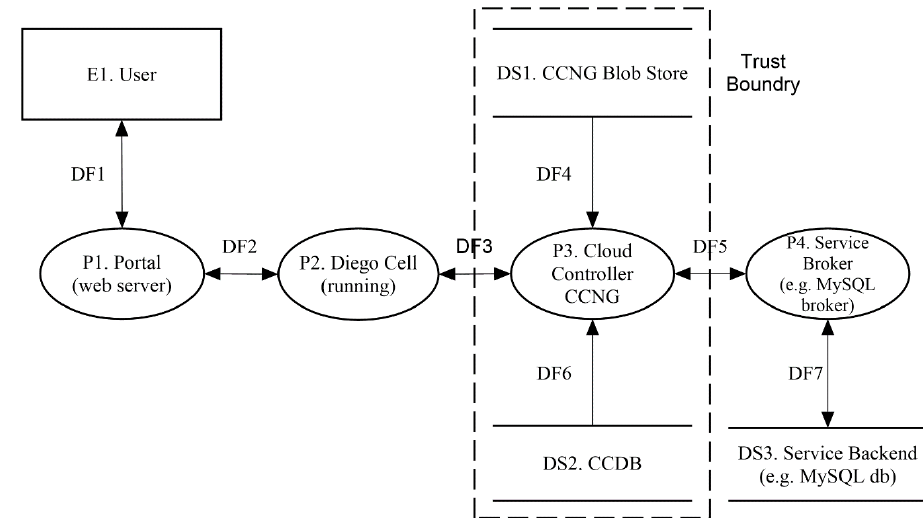
Figure 2. Data Flow Diagram for User Table 3. LINDDUN privacy mapping for Cloud Foundry hosted